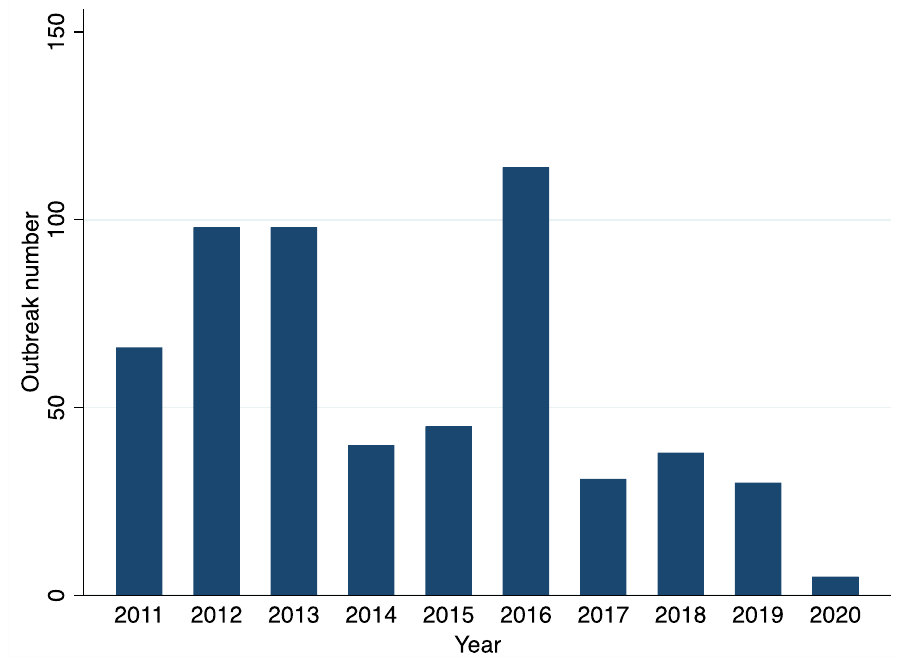
Figure 3. Cholera outbreaks ( n = 565) by year, India, 2011 – 2020.